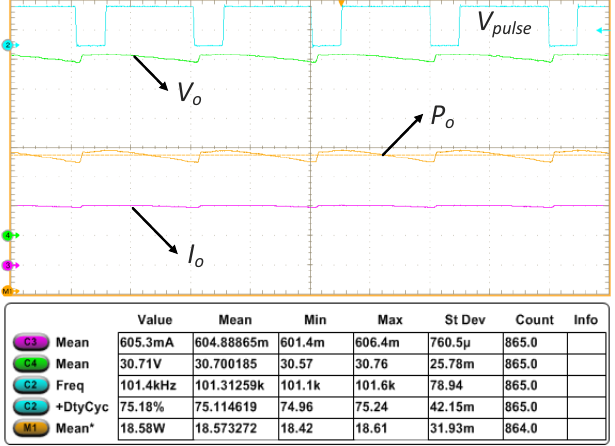
Figure 17. Output voltage and current graph.